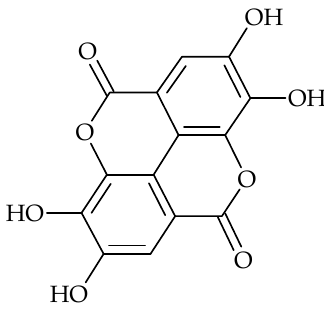
Figure 3. Chemical structure of ellagic acid.